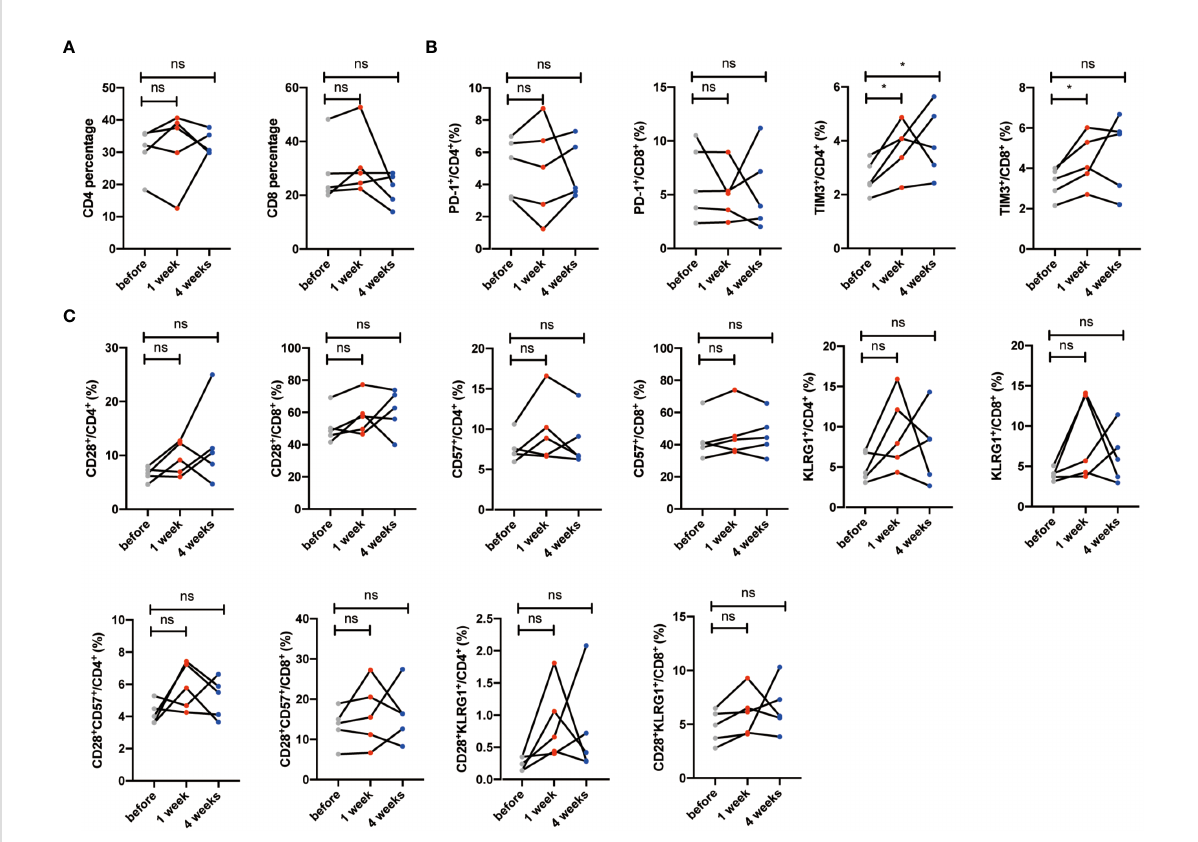
FIGURE 6 Senescent T cells and exhausted T cells have no signi fi cant changes in the saline group. (A) Percentages of CD28 - , CD57 + , KLRG1 + , CD28 - CD57 + , and CD28 - KLRG1 + T cells were analyzed by fl ow cytometry on the 1 week and 4 weeks after saline injection. (B) Percentages of PD-1 + and TIM-3 + T cells were analyzed by fl ow cytometry on the 1 week and 4 weeks after saline injection. Each marker has detected fi ve volunteers. * p < 0.05. ns, no